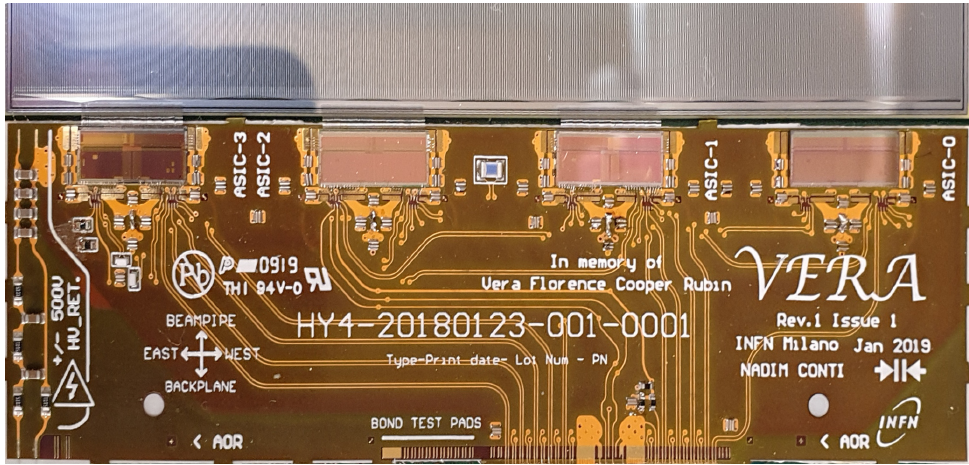
Figure 9. SALT mounted on the hybrid and connected to the